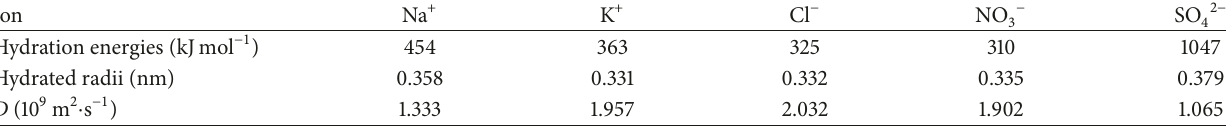
Table 3: Hydration energies, hydrated radii, and diffusion coefficients of some ions [30, 31].